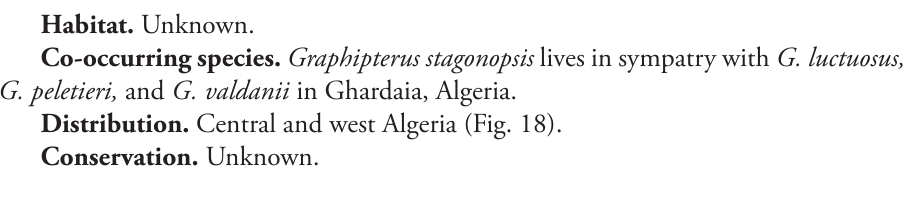
a b Figure 24. Dorsal habitus of Graphipterus a G. multiguttatus b . G. peletieri. Habitat.